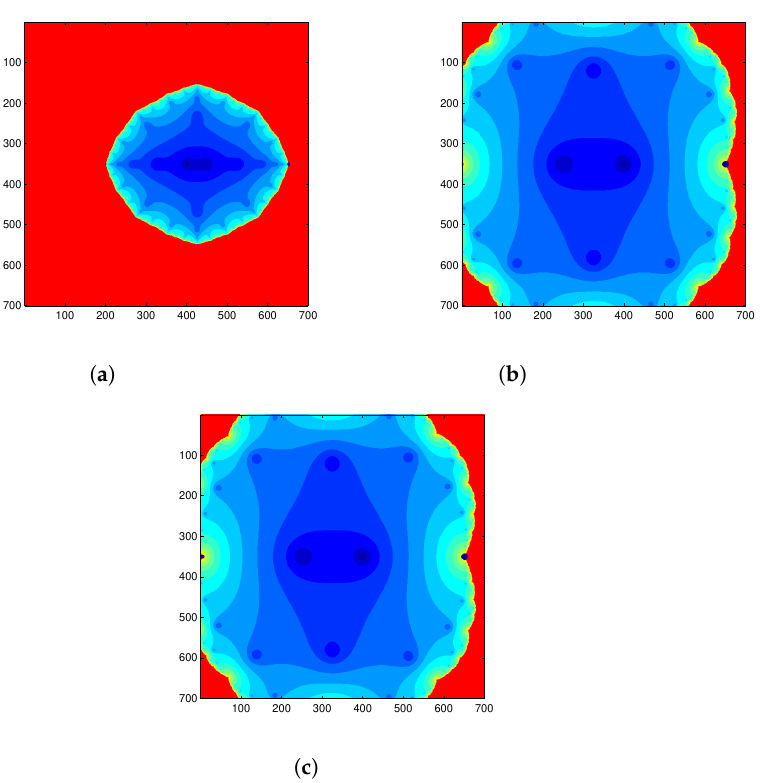
by different methods. ( a ) Newton ( z − 3 )